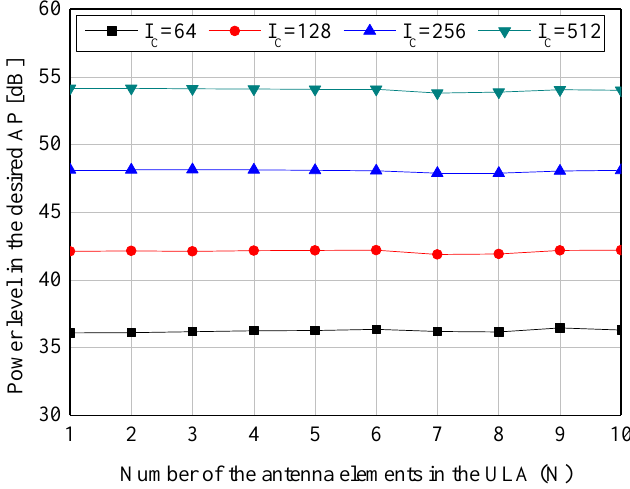
Figure 2. Simulation results of the system model with various N and I C - Power levels, P ( ϕ 1 ) , in the desired direction of ϕ 1 = 0.